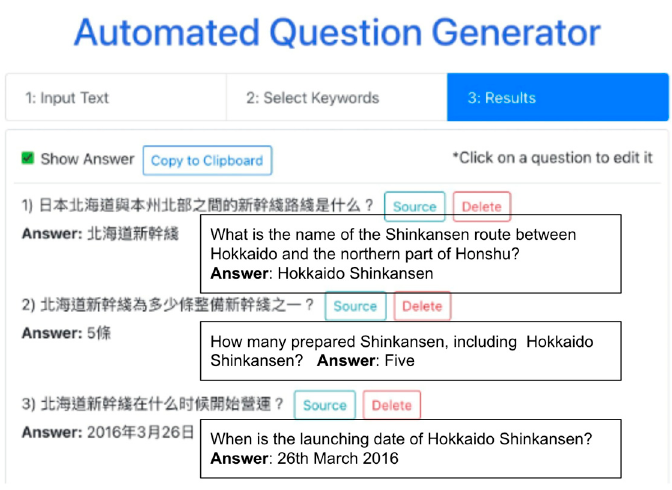
Figure 7. Step 3: questions are generated and displayed on the user screen.